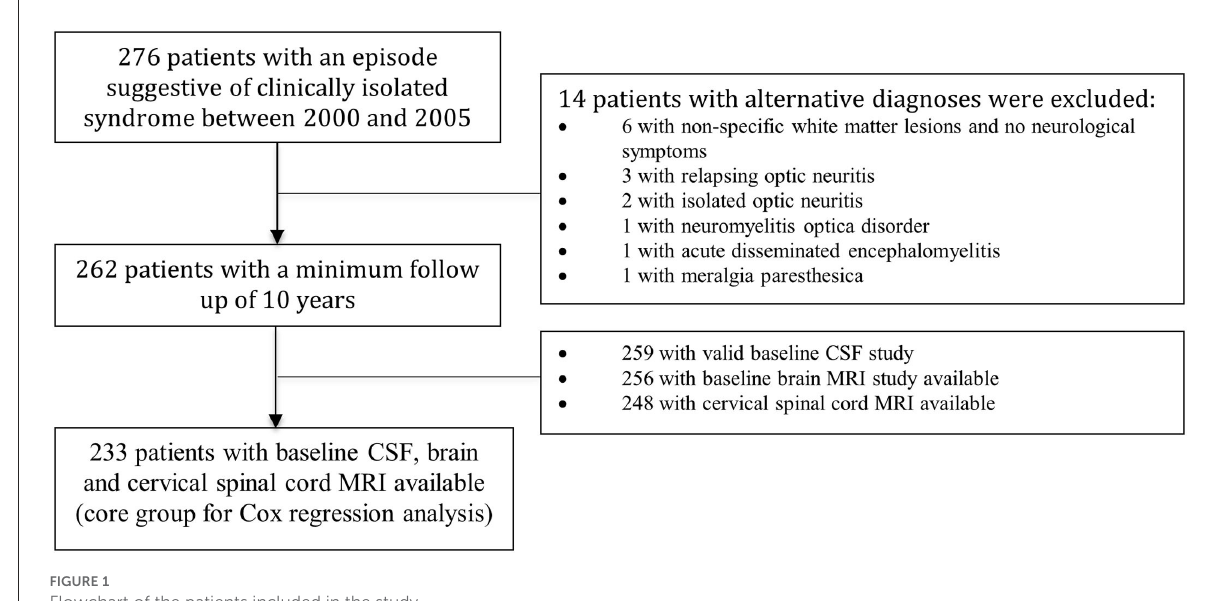
FIGURE1 Flowchart of the patients included in the study.